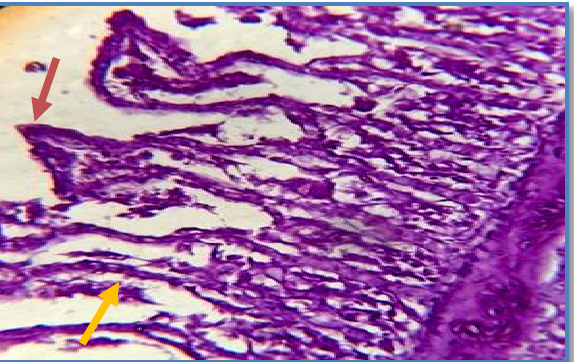
Figure, 1: Longitudinal section of filament showing fusion of secondary lamellae ends with cellular atrophy during winter season ( ) and detachment of lamellar epithelium ( ), (X400 PAS stain).